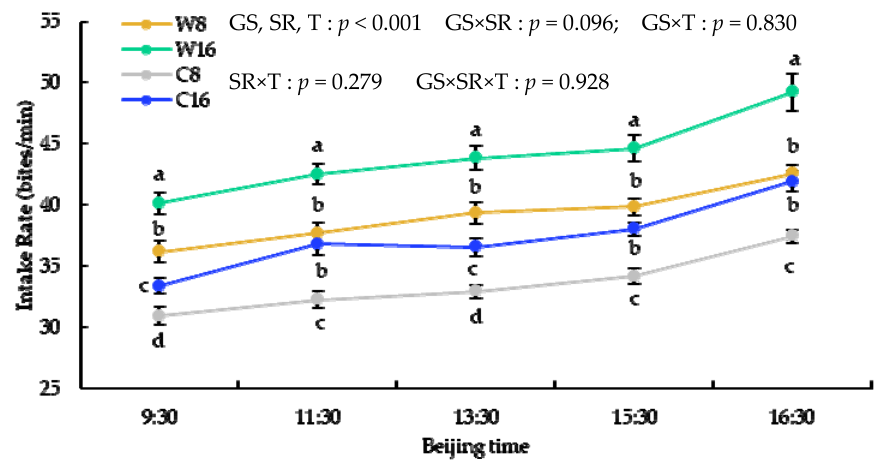
Figure 4. The x–axis is the time of day, and the y–axis is the intake rate. GS = grazing season; SR = stocking rate; T = times.